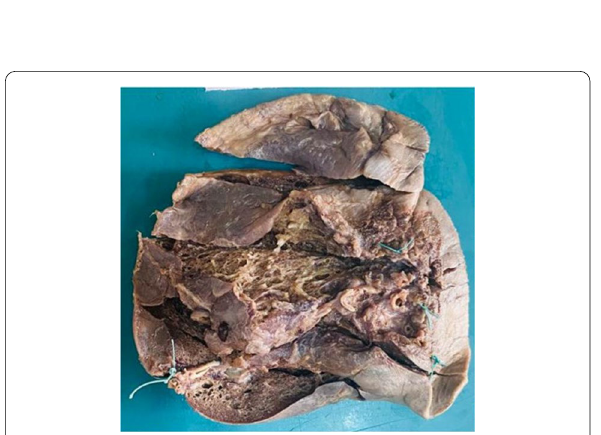
Fig. 4 Resected gross specimen of right lower lobe showing multiple small cystic spaces varying in size from 0.2 to 1 cm in center as well as the periphery with no visible areas of hemorrhage, calcification or mass